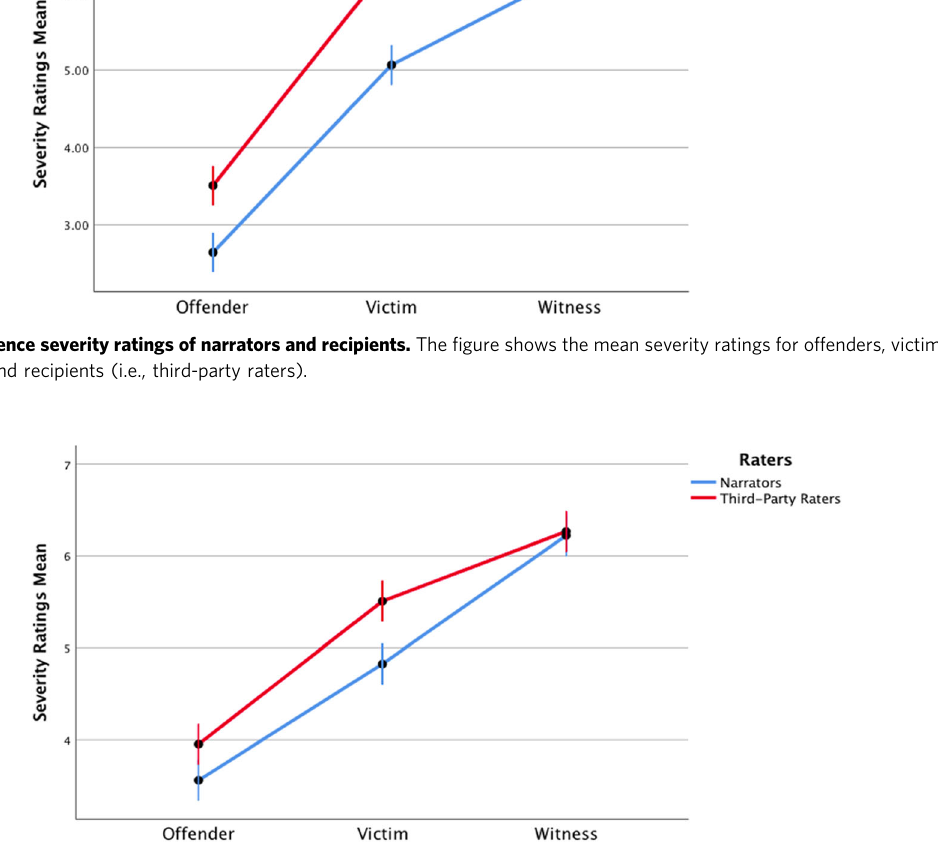
Fig. 3 Mean psychological violence severity ratings of narrators and recipients. The fi gure shows the mean severity ratings for offenders, victims and witnesses divided into narrators and recipients (i.e., third-party